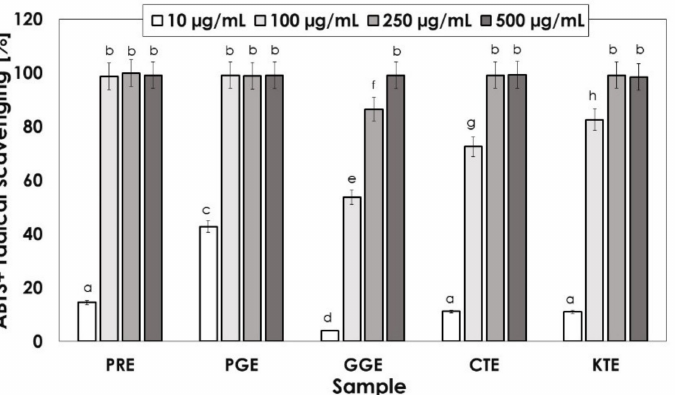
Figure 2. Kinetics of the absorbance changes in ABTS solutions in the presence of various concentra- tions of water–ethanol extracts PRE ( P. rhoeas L.), PGE ( P. granatum L.), GGE ( G. globasa L.), CTE (C. tinctorius L.), KTE (C. ternatea L.). Values are means of three replicate determinations ( n =